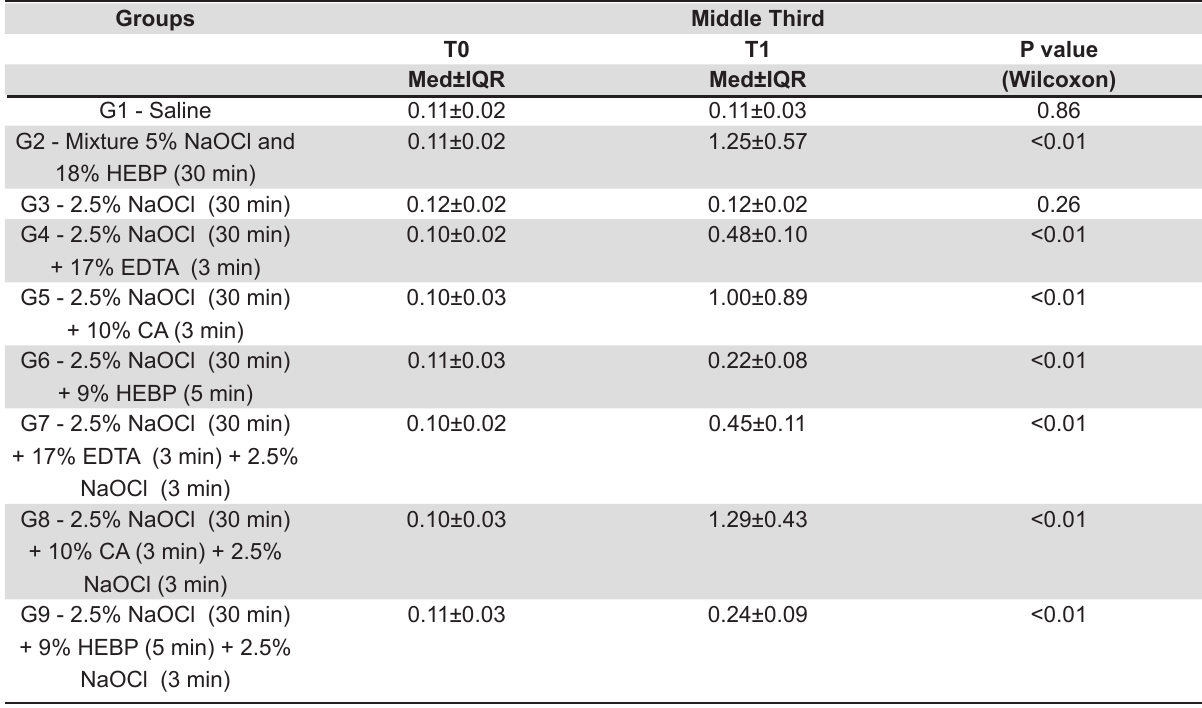
Table 2- Median (Med) and interquartile range (IQR) and P values (Wilcoxon test) for roughness analysis in the middle third before (T0) and after (T1) the application of the irrigation regimens